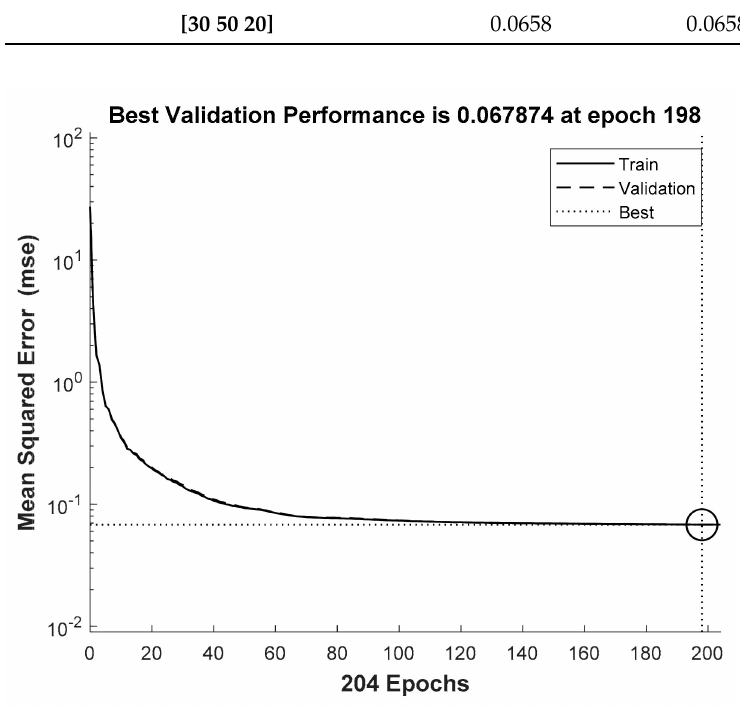
Figure 6. Learning curve of the network with one hidden layer.